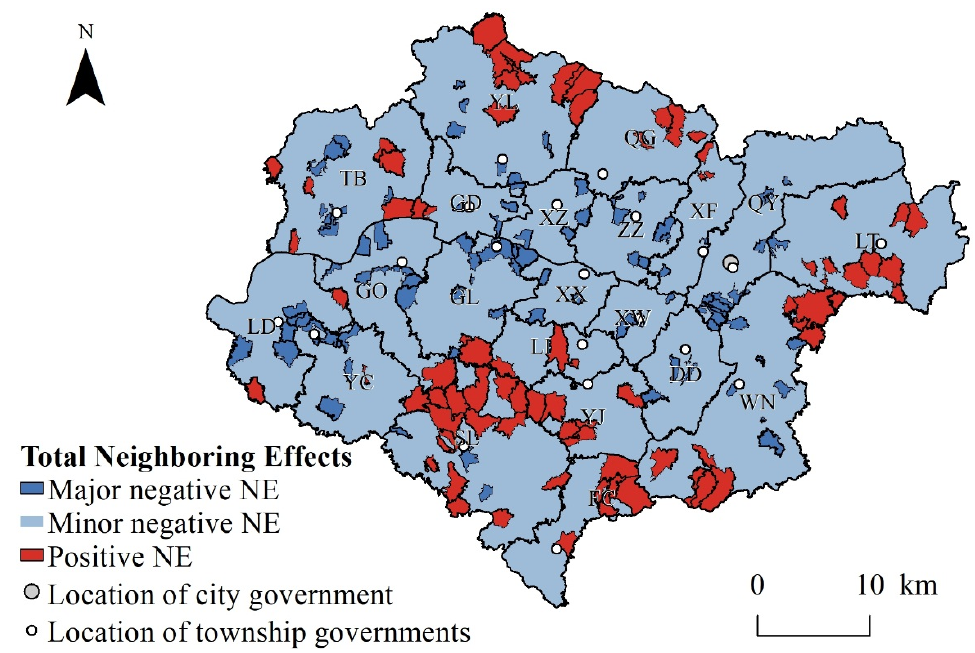
Figure 6. Total neighboring effects by villages in Xintai City.